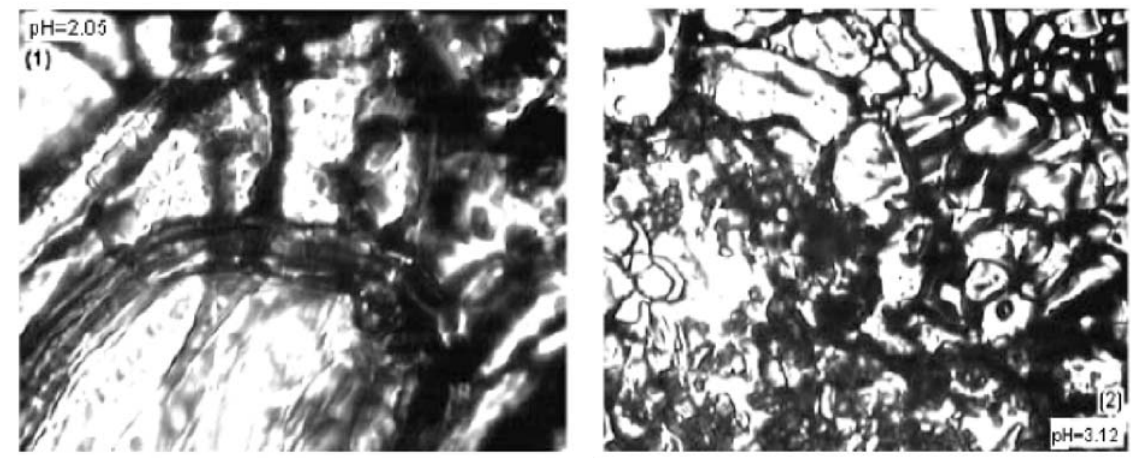
Fig. 8 Microscopic images of solid PEG-rich phase in the presence of H 2 SO 4 , pH = 3.12 after metal species extraction (Cd i = 57.05 µ g/mL, [I − ] ad = 0.06 mol/L: (1) detail at 600x; pH = 2.05; (2) detail at